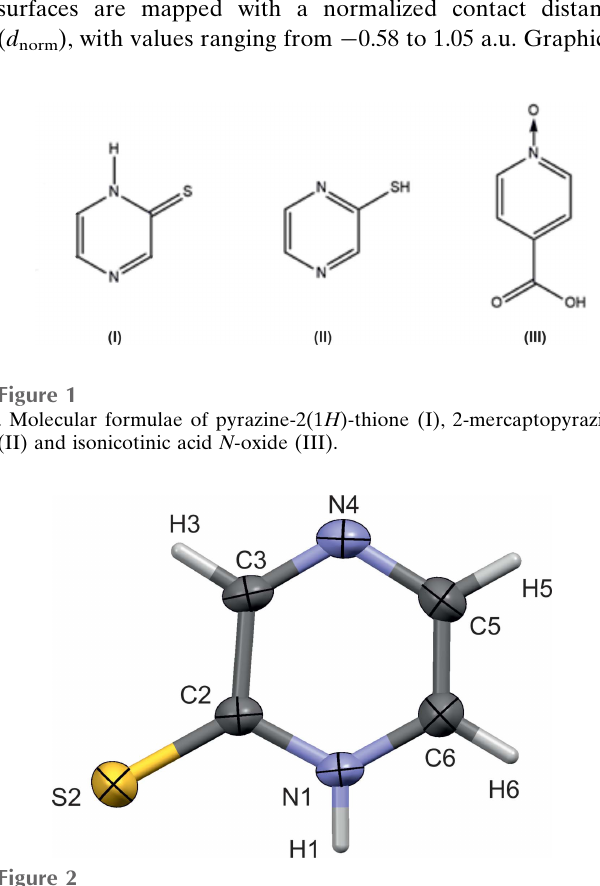
Figure 2 The molecular structure of pyrazine-2(1 H )-thione, showing the atom- labelling scheme and displacement ellipsoids at the 50% probability level.